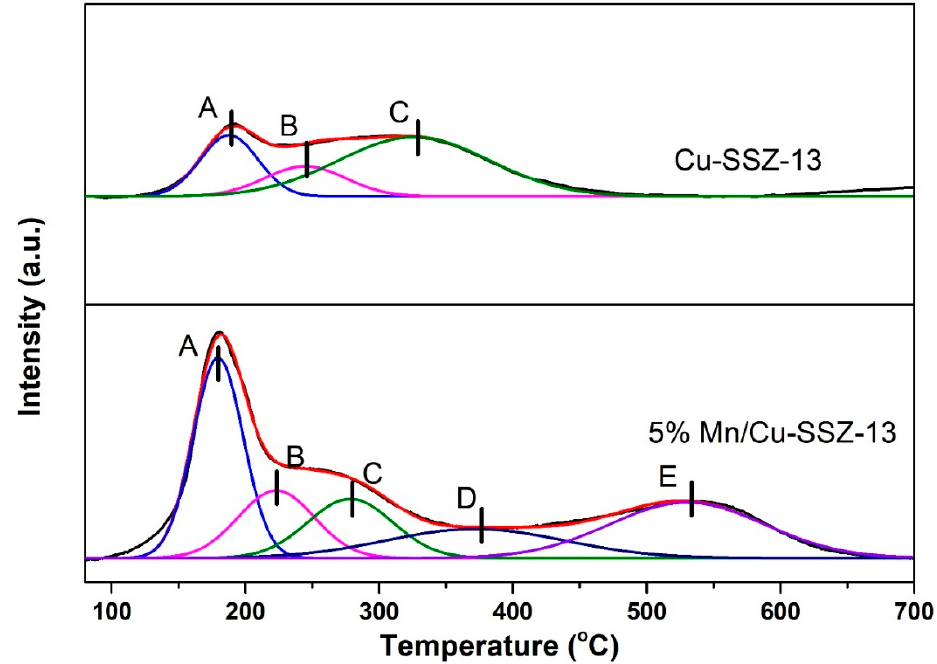
Figure 4. H 2 -TPR curves of Cu-SSZ-13 and 5% Mn/Cu-SSZ-13.